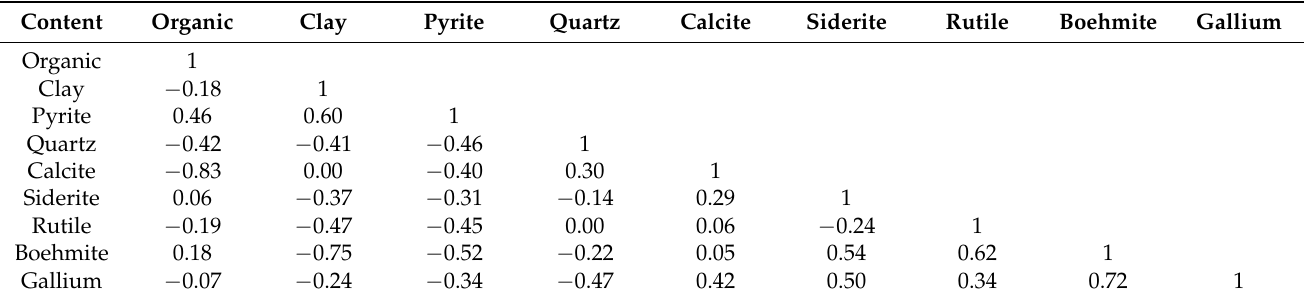
Table 3. The cross-correlation coefficients of all contents appear in Table 1.